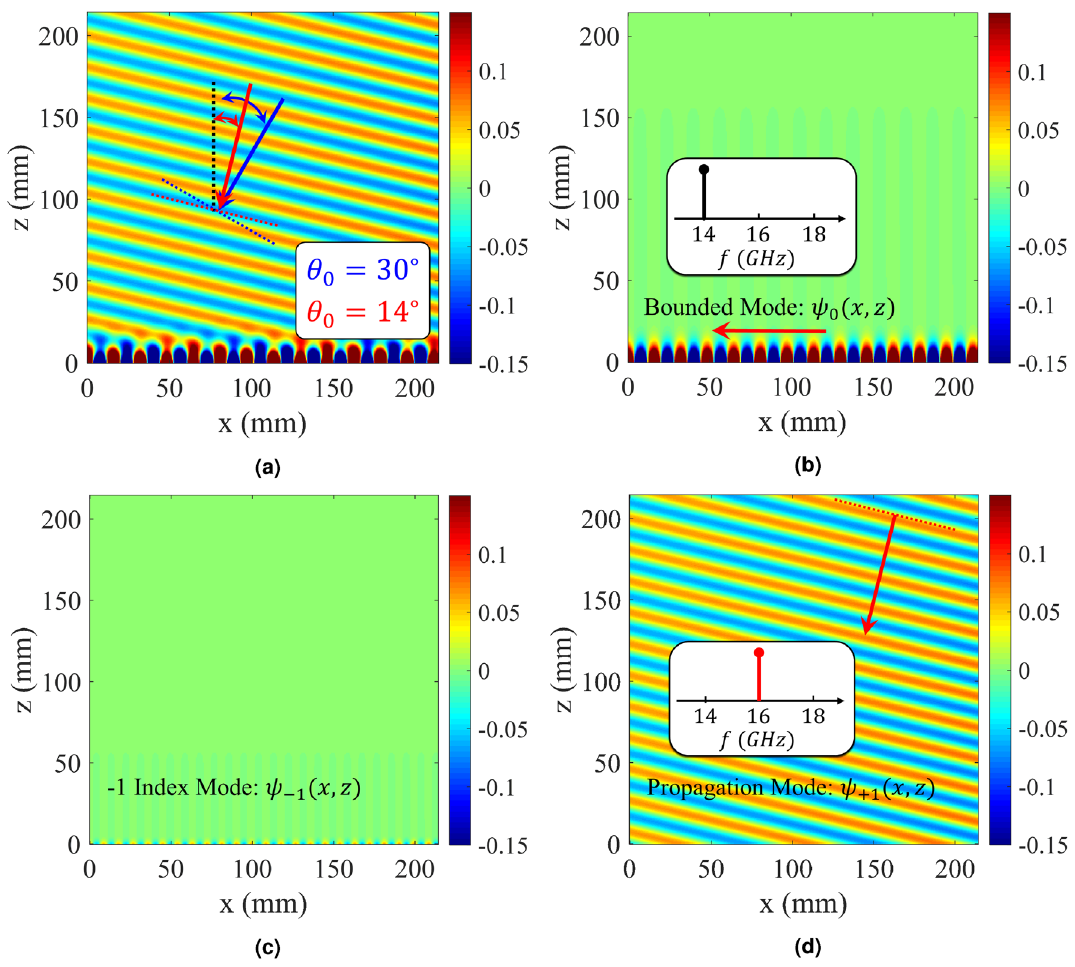
Figure 9. Analytical results of the proposed spationtemporally modulated hologram in receiving mode. ( a ) Total field, ( b ) fundamental mode, ( c ) (− 1)-index mode, and ( d ) radiation